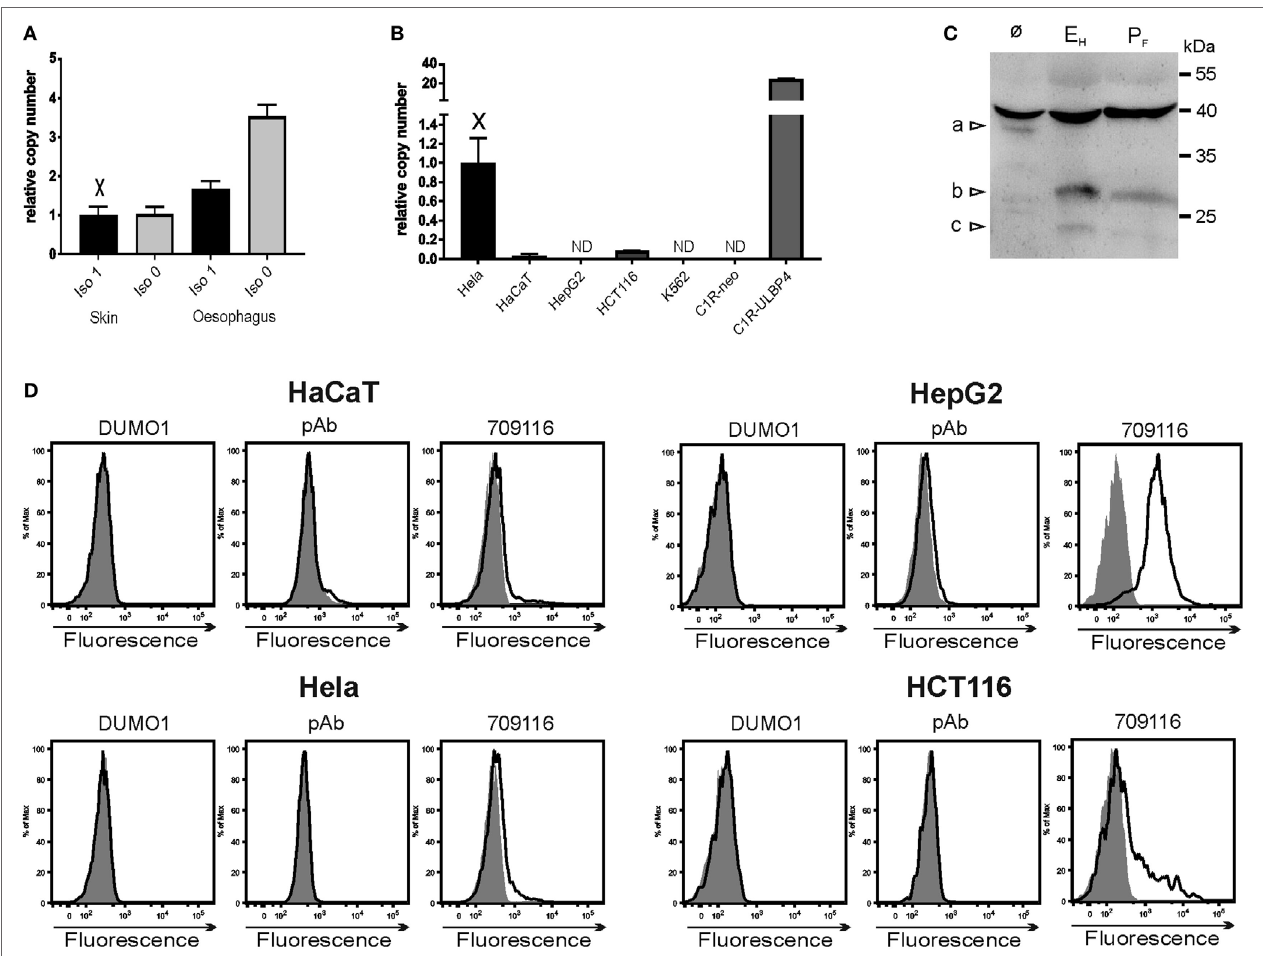
FigUre 4 | Detection of ULBP4 expression. (a) Abundance of ULBP4 isoforms 0 and 1 in human skin or esophagus as determined by quantitative PCR (qPCR). (B) Abundance of ULBP4 transcripts in various human cell lines as determined by qPCR. Abbreviation: ND, not detectable. (c) ULBP4 glycoproteins in lysates of HeLa cells were detected after immunoprecipitation with mAb DUMO1 with ULBP4-specific pAb in immunoblotting. Lysates were treated with endoglycosidase H (E H ) or PNGase F (P F ) before SDS-PAGE where indicated. Triangles indicate positions of glycosylated ULBP4 [a] in untreated lysates, and putative deglycosylated isoforms 0/1 [b] or 3 [c] in lysates treated with endoglycosidase H and PNGase F. (D) Binding of ULBP4 antibodies (solid lines) to various human cell lines. Control stainings are